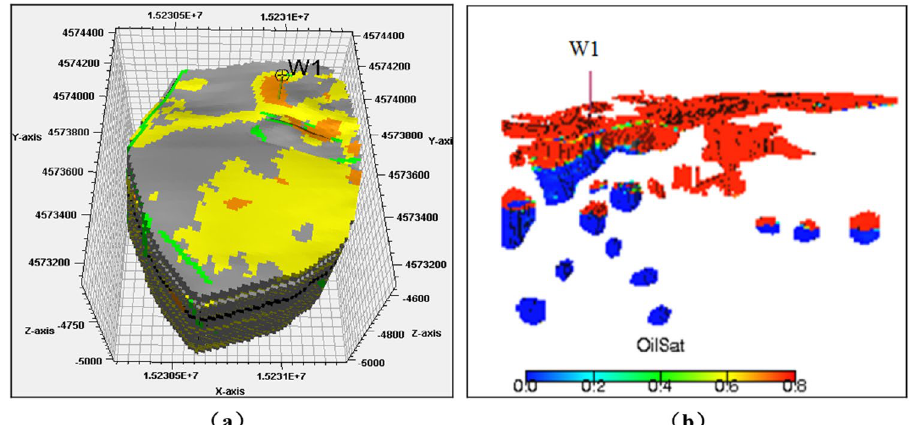
Fig. 5 W1 well curve fitting: a log–log plot; b pressure history match plot; c semilog plot Fig. 6 Geological modeling